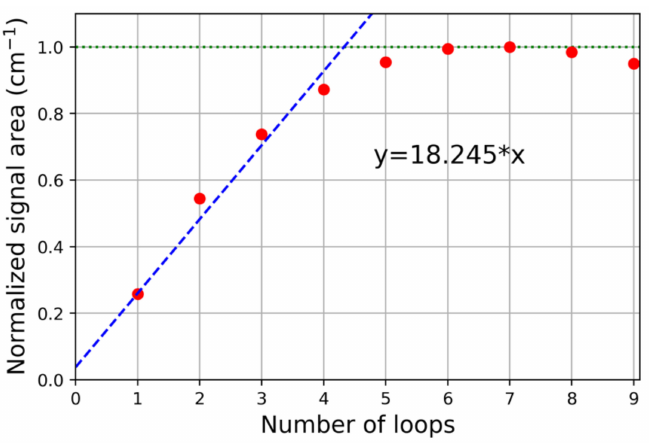
Figure 5. Adsorption isotherm of n -butane on SZ at T = 308